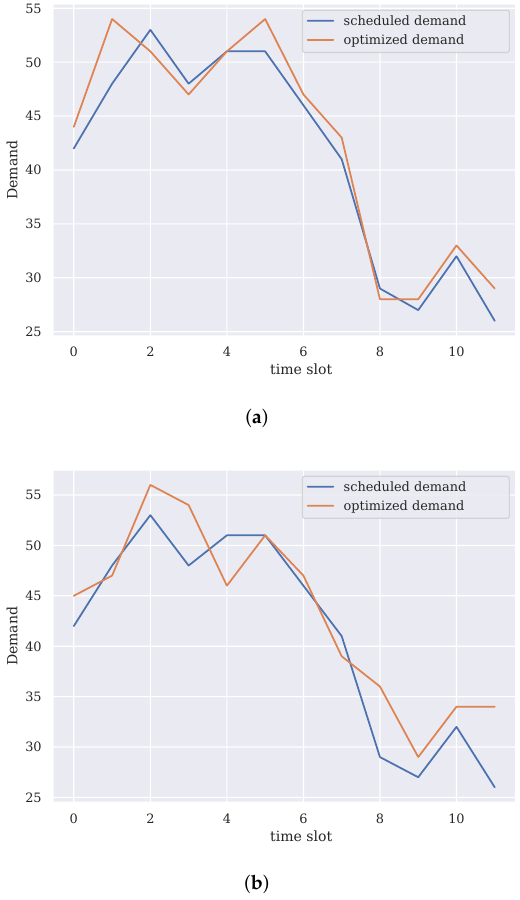
Figure 15. Variations in flight demand through optimizations using PSO at LGW. ( a ) PSO: 10%- restricted optimization. ( b ) PSO: 25%-restricted